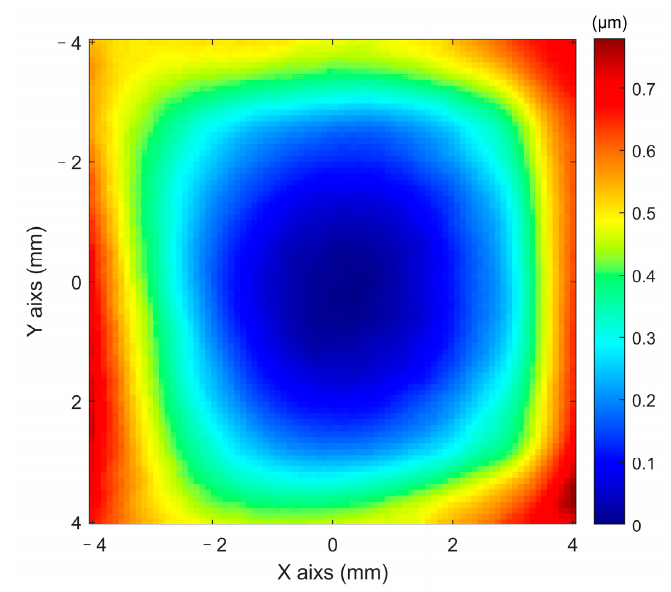
Figure 5. Thermally induced wavefront aberration. In order to understand the main wavefront types, SID4 was used to decompose the Legendre polynomial of the wavefront aberration in Figure 5. Figure 6 shows the first 21 terms in the analysis of the wavefront aberration’s Legendre polynomial coefficient. The fourth, the sixth, and the thirteenth terms are dominant; the fourth and the sixth terms are the defocus of x and y, respectively. The thirteenth item was dominant because the gain medium and the pump cross-section were both square, and the distance between the edge of the pump area and the central point was different, resulting in different heat dissipation capabilities. These items can be compensated for by wavefront correctors.